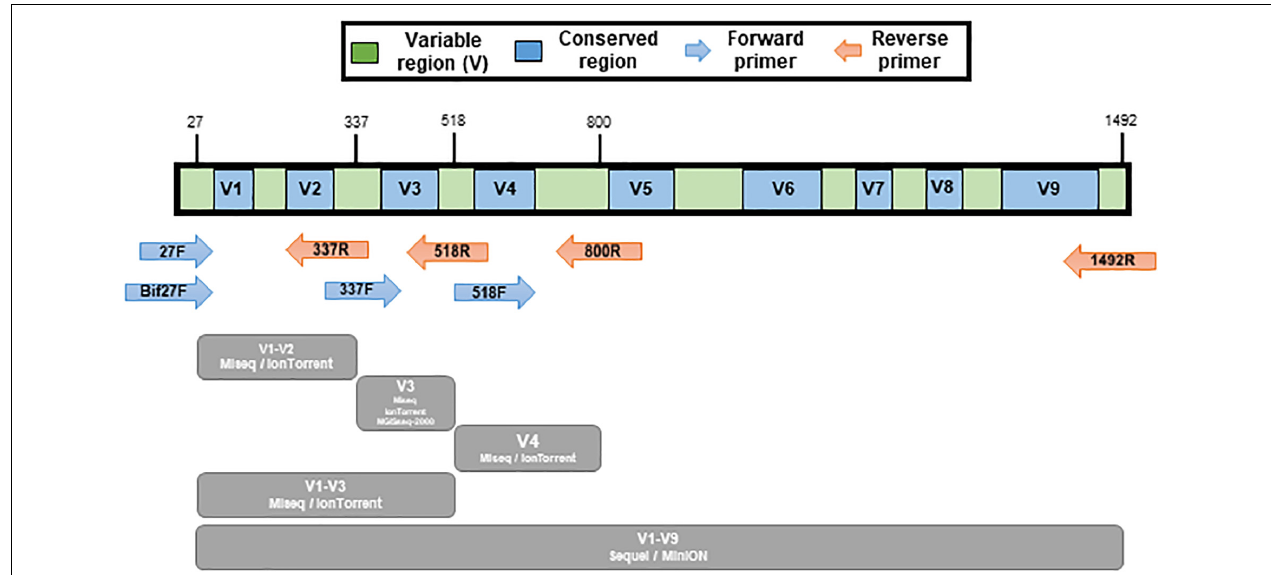
FIGURE 2 | Illustration of variable regions within the 16S rRNA gene and the various primer pairs used for mock sample sequencing. Conserved regions are show in blue color and variable regions are green. Amplicon regions of each sequencing platform are shown in gray